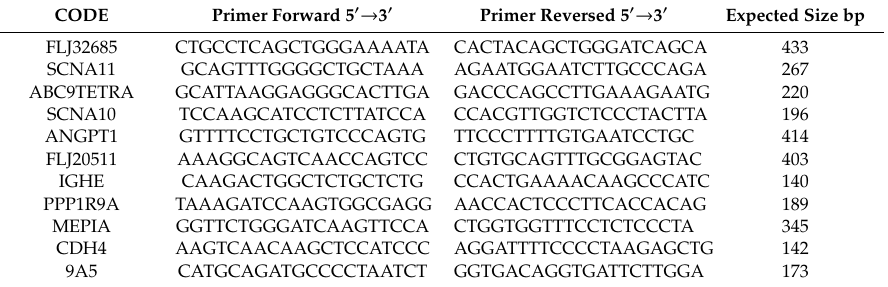
Table 1. List of canine DNA primer pairs used for PCR-amplification along with approximate product size and annealing temperature [14].